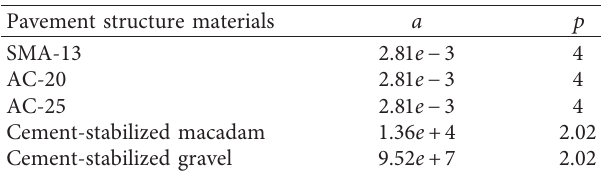
Table 2: Summary of material damage parameters a and p for different pavement structures.